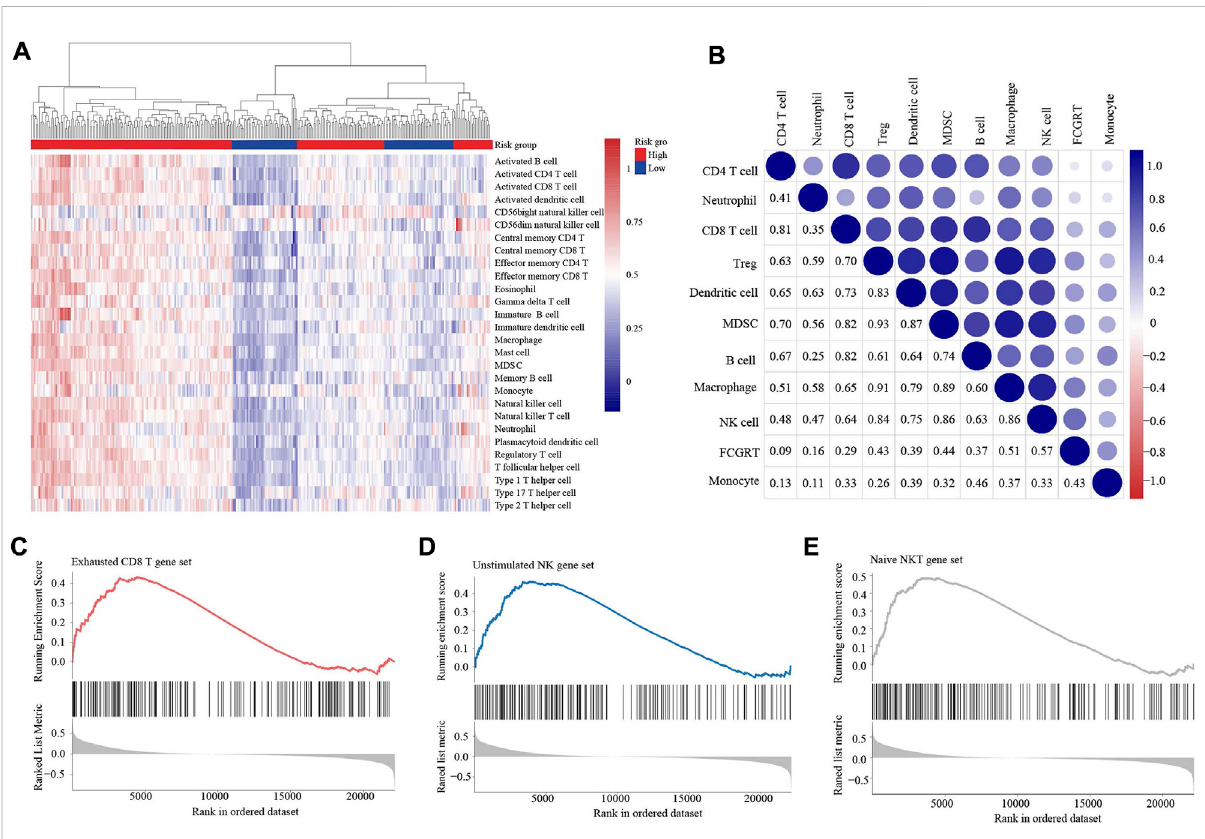
FCGRT-shaped immunosuppressive context (A) Heatmap of the in fi ltration pro fi le of 28 immune cells in the two groups. (B) Correlation between FCGRT expression and immune cell in fi ltration. The p -value of the correlation is indicated in box. (C – E) The enriched gene sets in the FCGRT high